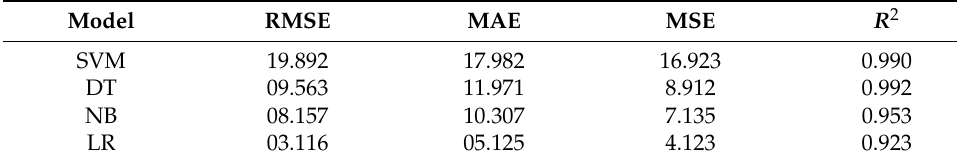
Table 3. Performance metrics values for Machine learning